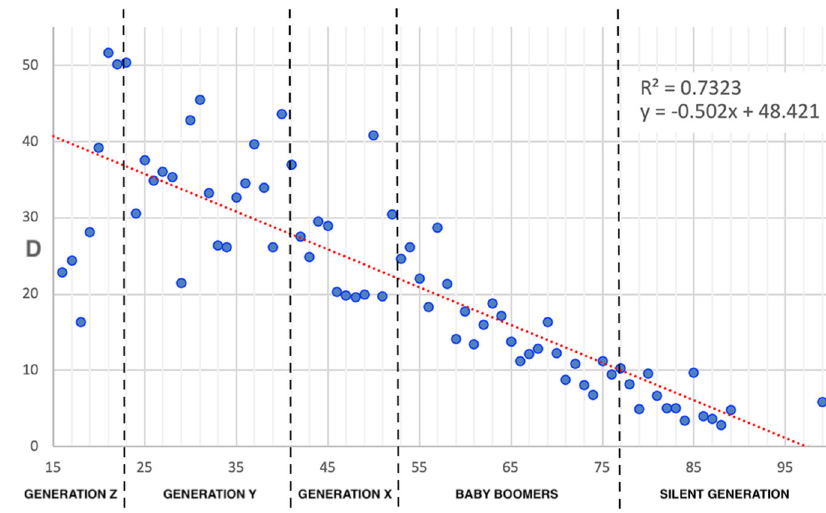
Fig. 5 The Margalef diversity index (D). Richness of color vocabulary in participants of individual age years.